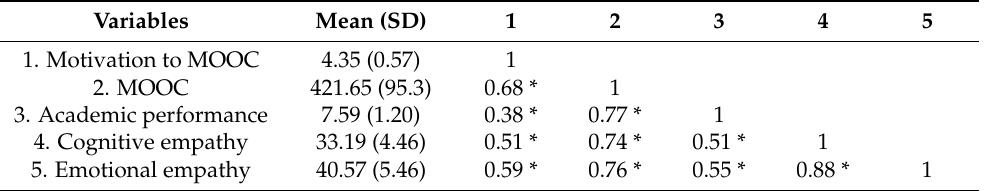
Table 3. Descriptive statistics (means and standard deviation) and bivariate correlations of the variables in the experimental group ( n =